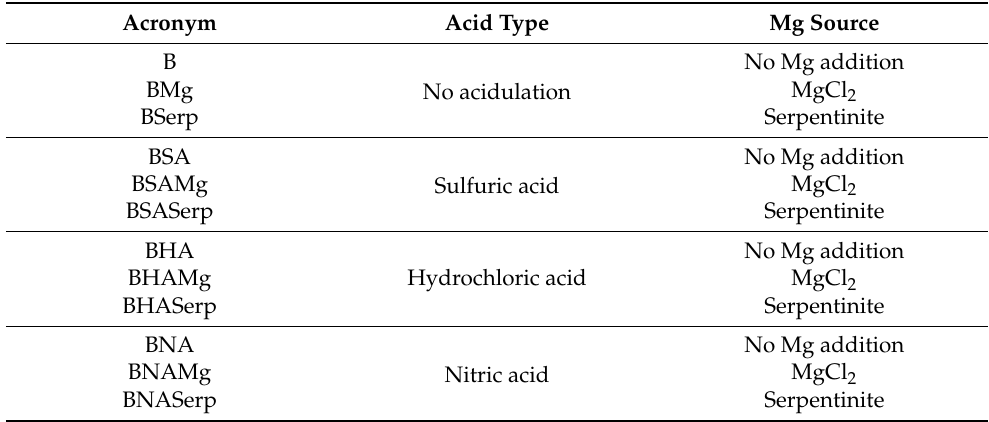
Table 1. Acronyms and synthesis route steps used in the production of biochar-based